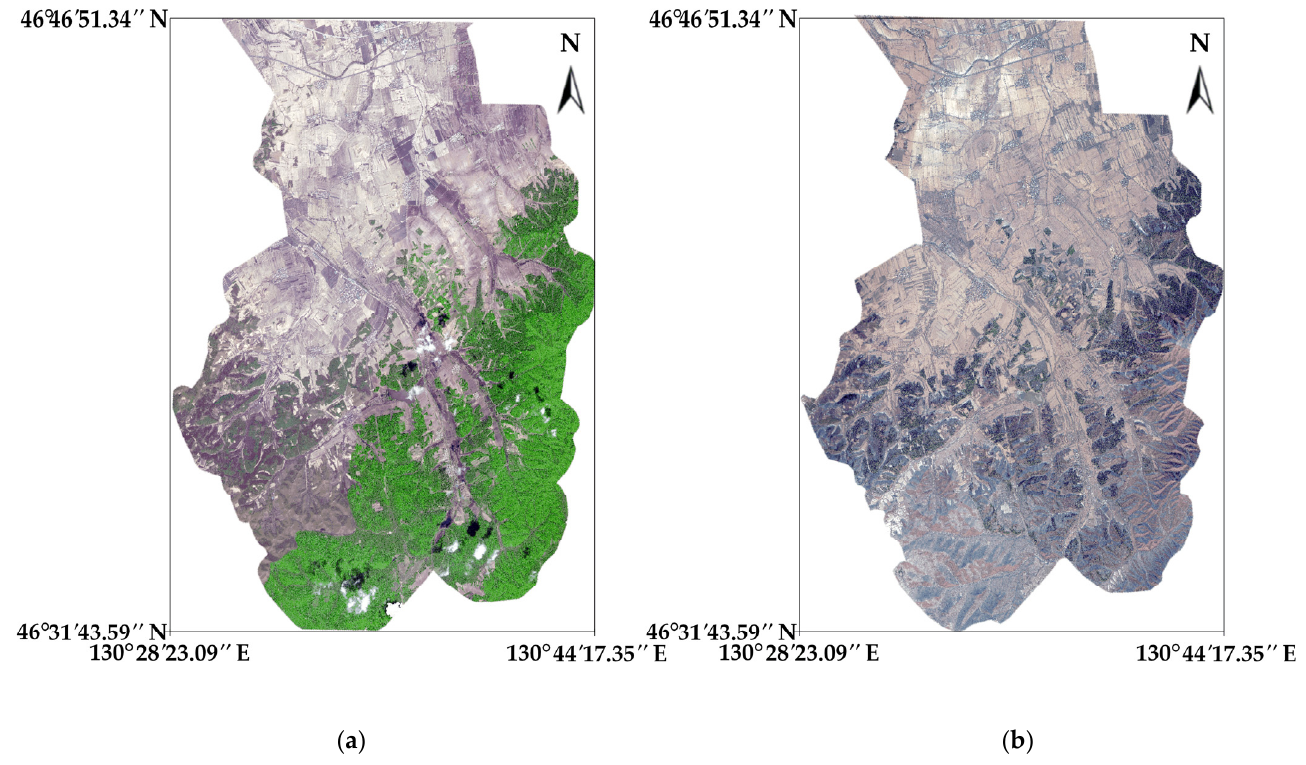
Figure 5. The pan-sharpened RGB images of two datasets. ( a ) HC2012 dataset. ( b ) HC2020 dataset. The HC2012 dataset was carried out based on the remote-sensing image of Huachuan County, Heilongjiang Province, China, collected by the ZY-3 satellite in 2012, whereas the HC2012 dataset was based on the same-site remote-sensing image collected by the GF-2 satellite in 2020.